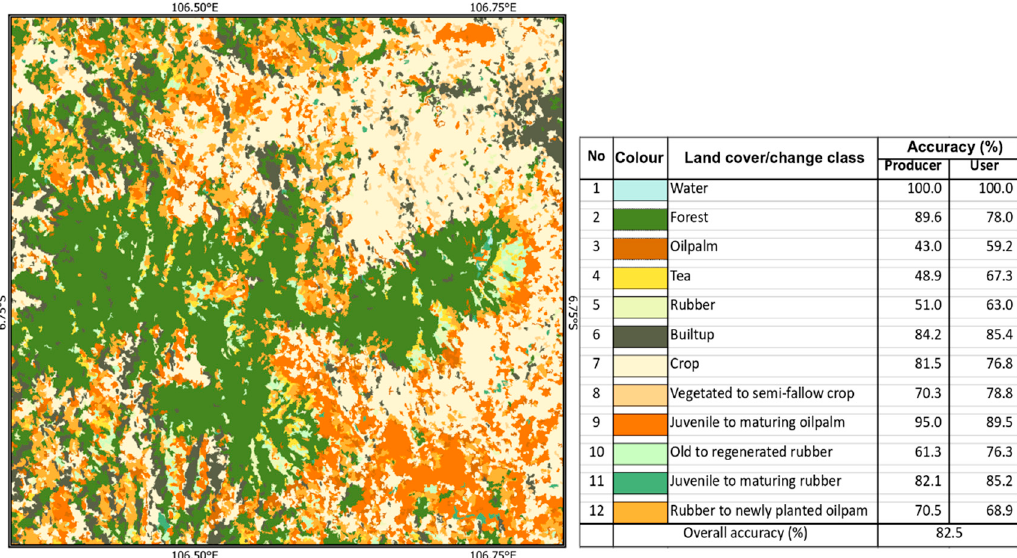
Figure 10. The distribution of 12 land cover/change classes resulting from RFG added with producer and user accuracies.